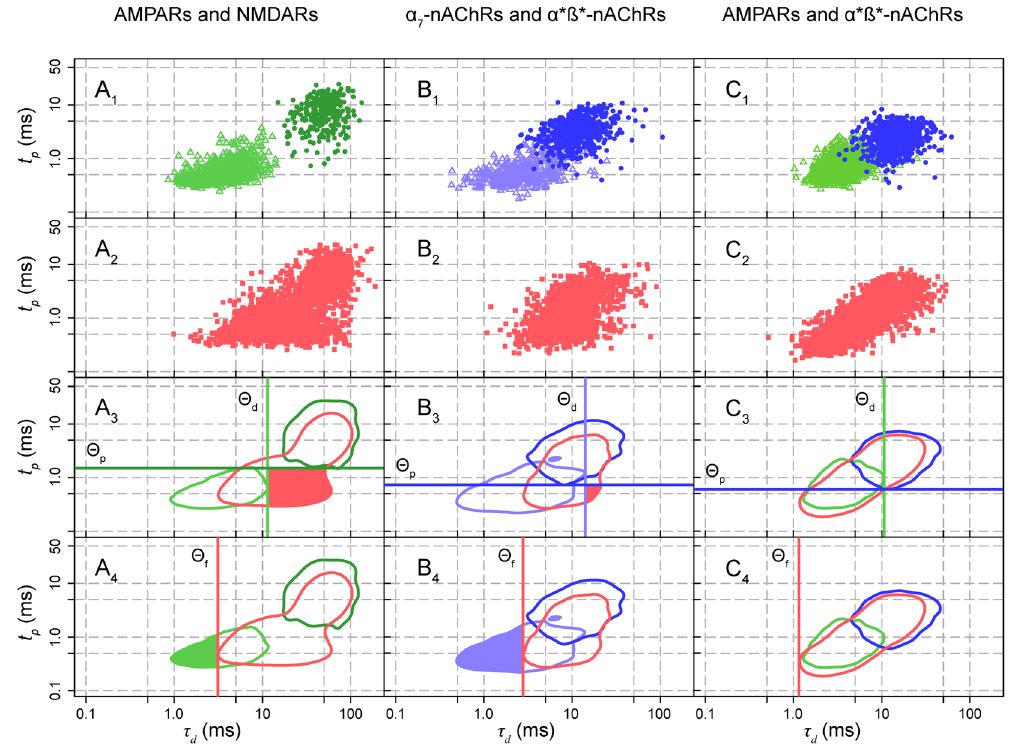
Figure 3. Co-localization of post-synaptic receptors deduced from pooled data. ( A ) AMPAR and NMDAR mEPSCs were collected at − 40 mV in 8 experiments. In 3 experiments AMPARs were subsequently blocked with NBQX and in the others NMDARs were blocked with D-APV. A 1 . Superimposed log( t p ) vs log( τ d ) distributions of the two single receptor mEPSCs: 1131 AMPAR mEPSCs from 5 experiments (open triangles, light green); 285 NMDAR mEPSCs from 3 experiments (filled circles, dark green). A 2 Distribution of mEPSCs recorded in the two-receptor situation (8 experiments). A 3 The 95% envelopes of the distributions shown in A 1 and A 2 were used to define τ d = θ d (light green) and t p = θ p (dark green) and to separate four quadrants (see methods). The lower right quadrant (shaded red sector), which is nearly empty in the superimposed single receptor plot (A 1 ), becomes the most populated in the two-receptor plot (A 2 ), with 850 out of 2375 mEPSCs ( µ = 35.8%). A 4 Fast rising events appear when D-APV is bath applied to block the slow events from A 2 to A 1 . The fraction of AMPAR events with a decay time constant faster than θ f (the smallest value of τ d for the envelope of the two-receptor mEPSCs) (light green sector) was 287/1131 ( ϕ = 25 . 4% .). ( B ) mEPSCs mediated by α 7 and α * β * nAChRs were recorded at − 60 mV. B 1 Single receptor α 7 -nAChR mEPSCs (purple open triangles, 5 experiments) and α * β * -nAChR mEPSCs (blue circles, 2 experiments). B 2 mEPSCs recorded in the two- receptor situation (red squares, 7 experiments) B 3 95% envelopes of the three distributions ( α 7 , purple; α * β * , blue; two-receptor, red). In one receptor conditions the lower left quadrant contained 334 α 7 events and 5 α * β * mEPSCs; the upper right quadrant 187 α * β * events and 2 α 7 events; the lower right quadrant contained 3 α 7 and 2 α * β * events. In two-receptor conditions 75 out of 2424 mEPSCs were found in the lower right quadrant ( µ = 3.1%). B 4 among the 427 α 7 -nAChR mEPSCs shown in Fig. B1, 210 (purple area in B 4 ) had τ d < θ f , where θ f is the fastest τ d observed in the two receptor conditions. ( C ) mEPSCs and sEPSCs (some recorded in presence of Sr 2 + ) mediated by AMPARs and α * β * nAChRs were recorded at − 60 mV in 10 experiments. C 1 single receptor conditions: AMPARs (light green open triangles, 2 experiments), α * β * nAChRs (blue filled circles, 8 experiments). C 2 mEPSCs and sEPSCs recorded in the two-receptor condition (red squares, 10 experiments). C 3 95% envelopes of the three distributions (AMPARs green, α * β * nAChRs blue, two-receptor red). No significant shaded area is present in the lower-right quadrant. The lower left quadrant contains 521 AMPAR events and 1 α * β * -nAChR events; the upper right quadrant contains 547 α * β * events and 11 AMPAR events. The lower right quadrant contains 2 AMPAR events and 7 α * β * events. In two-receptor conditions 16 out of 2192 mEPSCs were found in the lower right quadrant ( µ = 0.7%). C 4 DHßE does not induce the appearance of fast events. ϕ = 2 / 981 = 0 . 2%